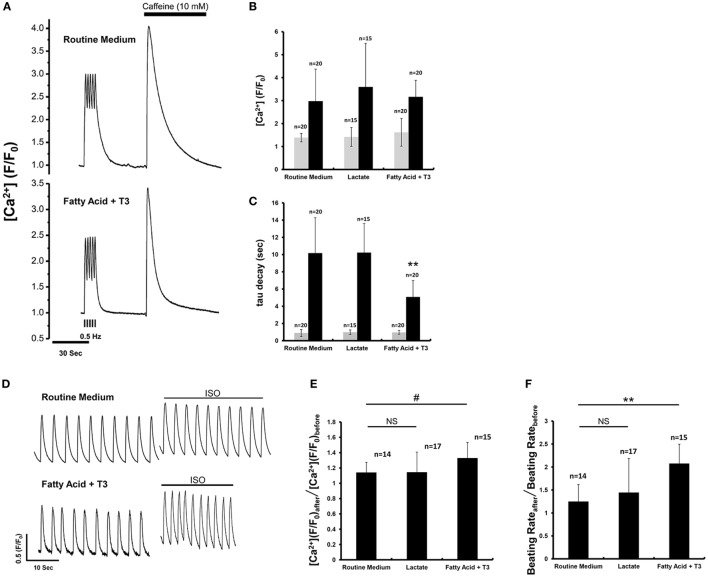
Fatty acid and T3-treated cardiomyocytes demonstrated improved calcium-handling in response to caffeine and isoproterenol. (A) The representative traces of calcium transient before and after caffeine application. (B,C) Calcium transients peak amplitude and decay time constant (tau) before (gray boxes) and after (black boxes) caffeine administration from cardiomyocytes maintained in the various culture conditions. Before caffeine administration, calcium transient peak amplitude and tau were recorded from the 0.5 Hz-paced cardiomyocytes. The double asterisks mean tau values of fatty acid and T3-treated cardiomyocytes were significantly different from the values of other two experimental groups. (D) The representative traces of calcium transient before and after isoproterenol application. (E) The ratio of calcium transient peak amplitude after isoproterenol application to that before isoproterenol application. Fatty acid and T3-treated cardiomyocytes demonstrated a greater response to isoproterenol than the other groups. (F) The ratio of beating rates after isoproterenol application to that before isoproterenol application. n indicates tested cells. #P < 0.05; **P < 0.001.